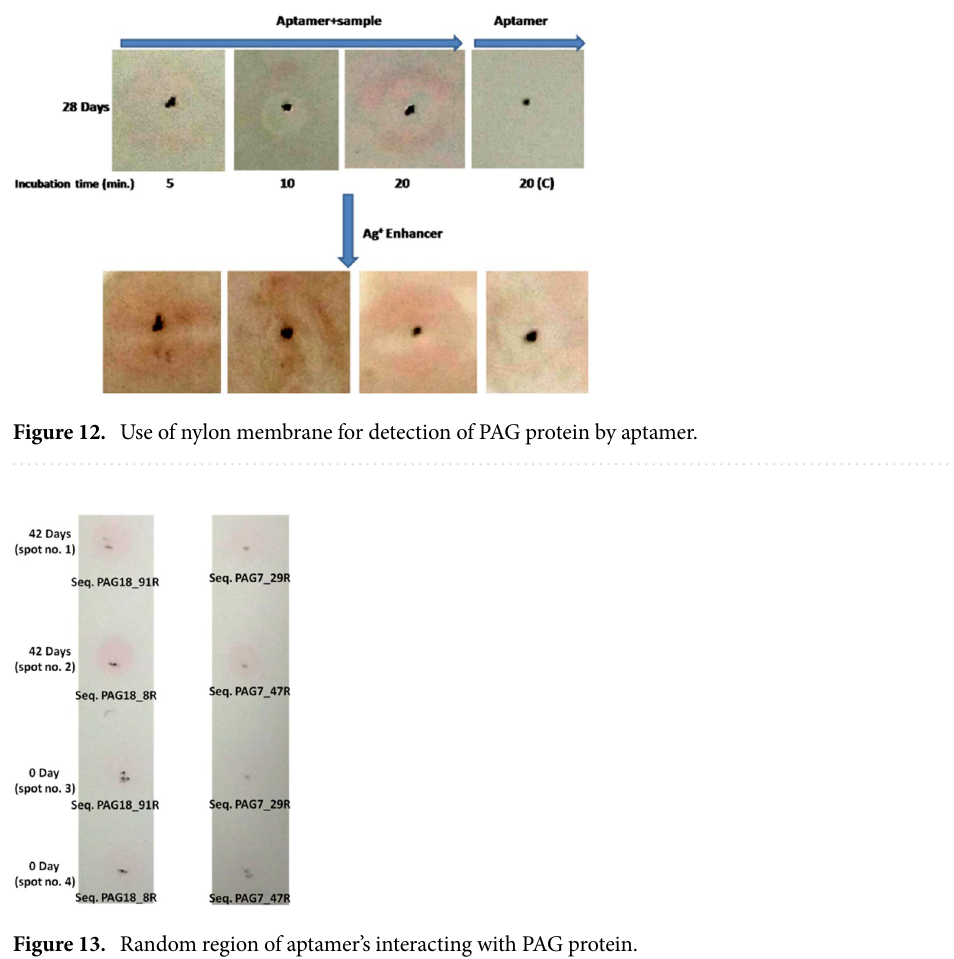
Figure 13. Random region of aptamer’s interacting with PAG